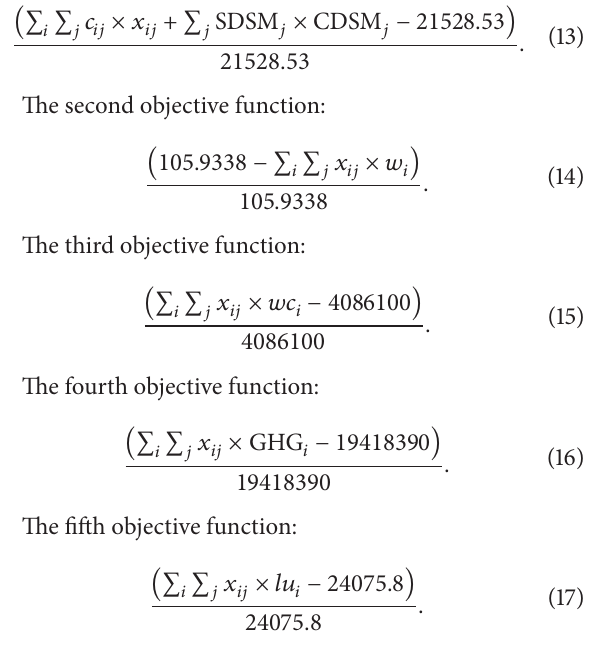
Figure 1: The role of each renewable energy source in electrifying the area under